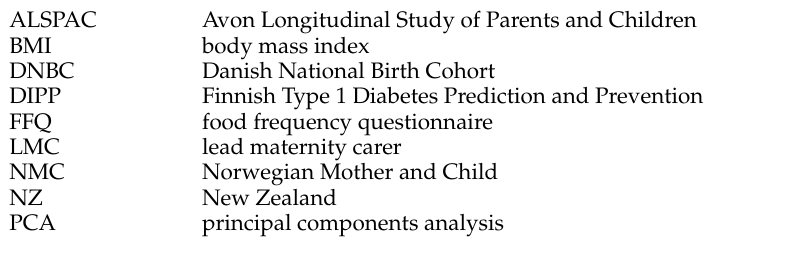
Table S1: Factor loadings of various food items in the four dietary components obtained using principal component analysis; Table S2: Univariate/unadjusted association of each maternal dietary pattern with adherence to dietary guideline recommendations for number of daily servings from each of the four main food